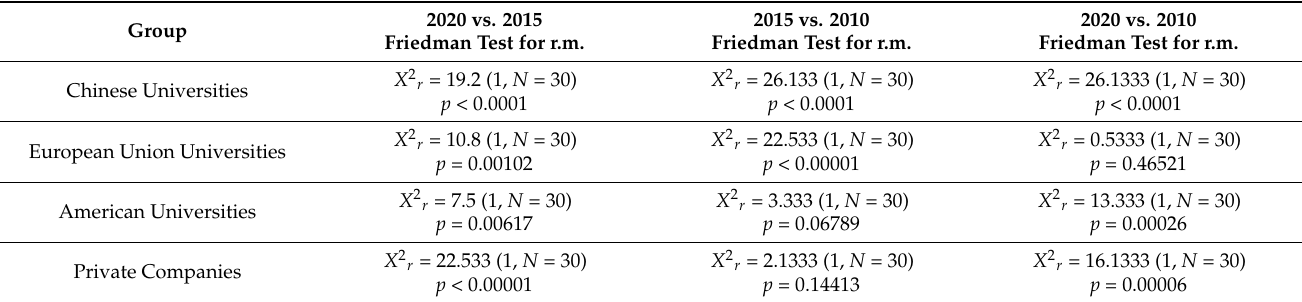
Table 2. Trends within groups over time (Friedman test for repeated measures).